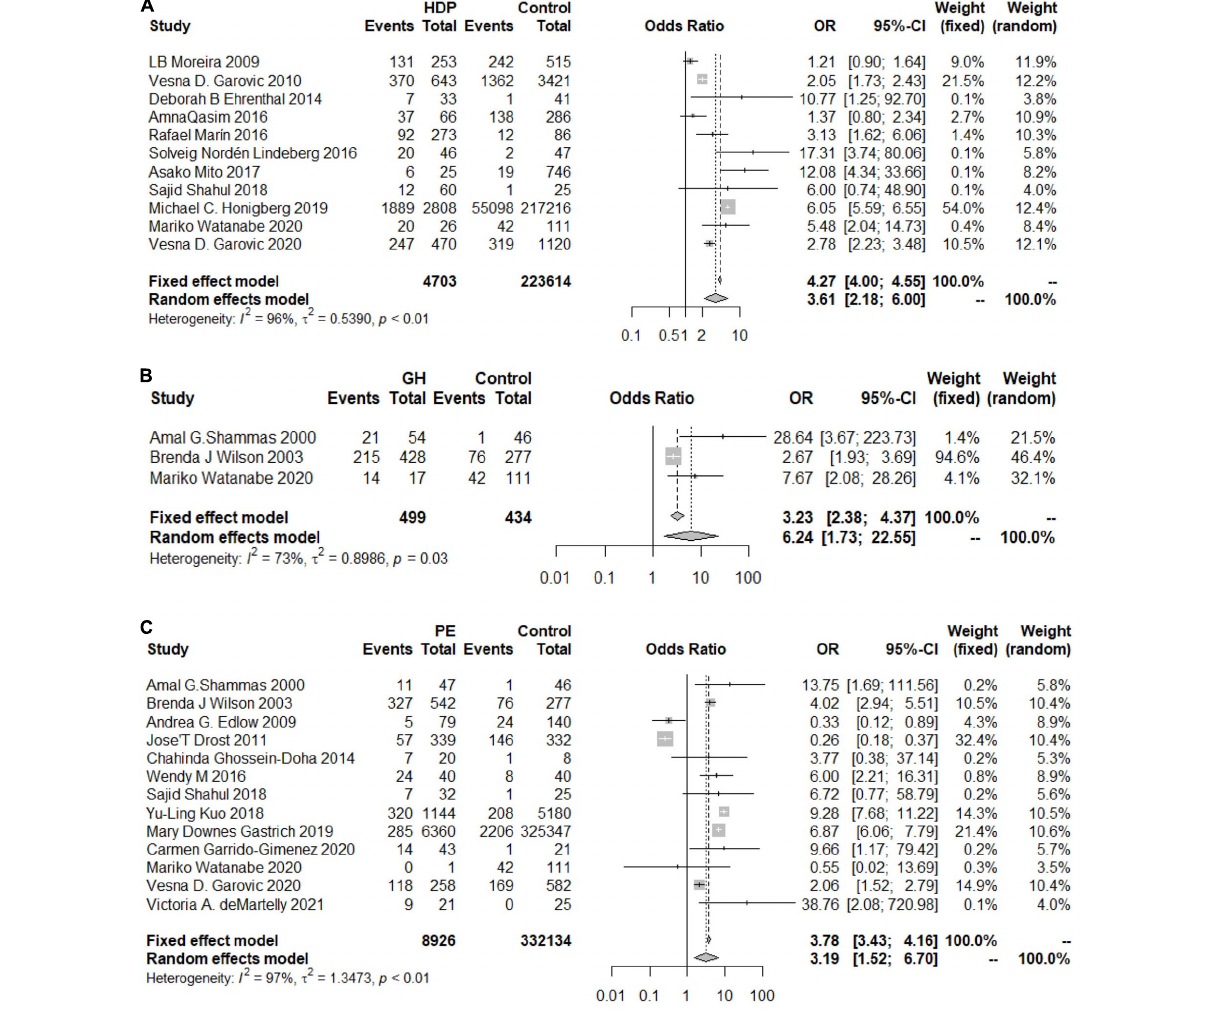
Frontiers in Cardiovascular Medicine |